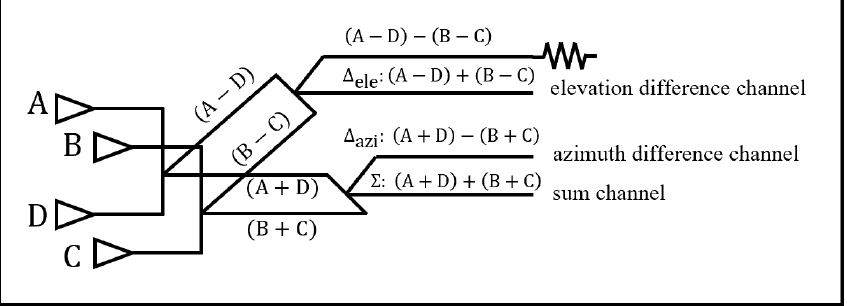
Figure 3. Monopulse comparator